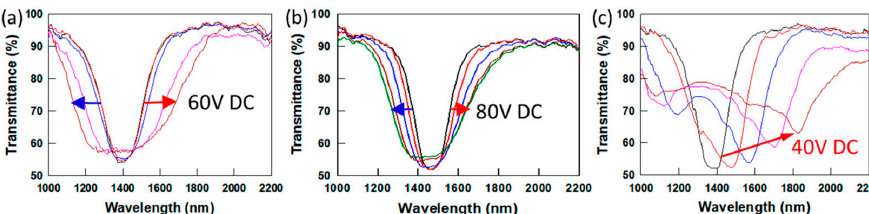
Figure 11. Transmission spectra of PSCLCs formulated with 3.5 wt.% R1011, 90.5 wt.% MLC-2079, and ( a ) 6 wt.% as-received C3M with an initial ion density of 7.6 × 10 13 ions cm − 3 , ( b ) 6 wt.% purified C3M with an initial ion density of 1.6 × 10 13 ions cm − 3 , and ( c ) 6 wt.% residual C3M with an initial